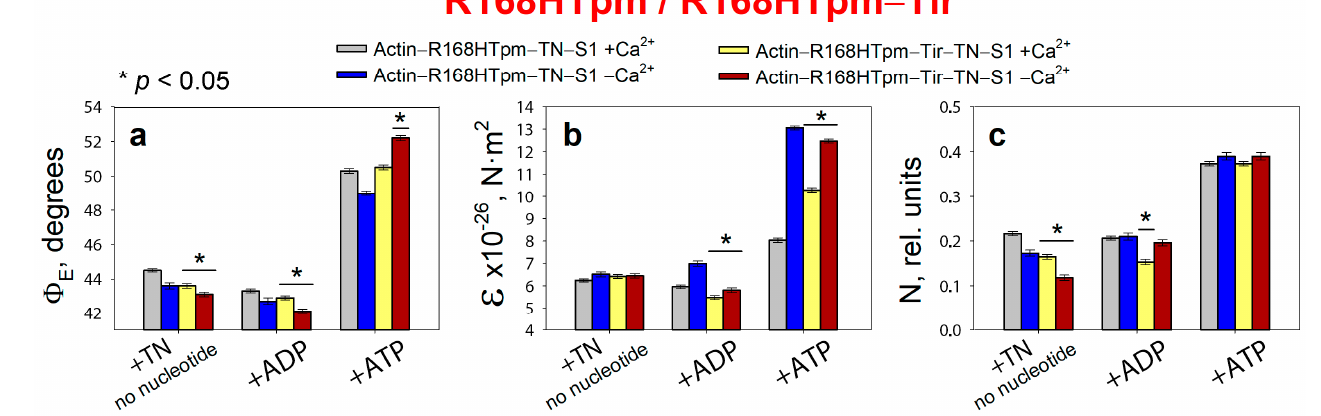
Figure 9. Influence of 5 µ M tirasemtiv (Tir) on the values of Φ E ( a ), E ( b ), and N ( c ) of the polar- ized fluorescence of S1-AEDANS, in the presence of R168HTpm, revealed in ghost muscle fibers under conditions simulating the sequential steps of the actomyosin ATPase cycle. The experimental conditions and designations are described in Materials and Methods. The fluorescence parameters presented here are compared with the data obtained in the same experiment when the muscle fibers containing the R168HTpm without Tir were used as a control. The data are averages for 4–6 fibers for each experimental condition. The data are presented as mean ± SEM. * p < 0.05 = difference between R168HTpm and